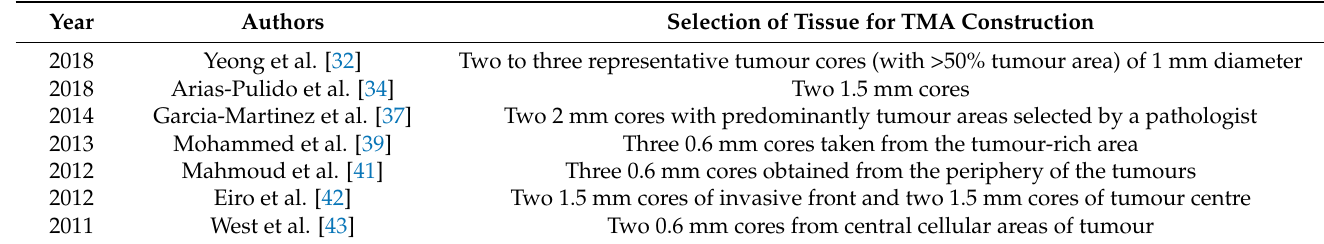
Table 2. Tissue selection in studies that used TMA for assessing TIL-Bs. Selection of Tissue for TMA